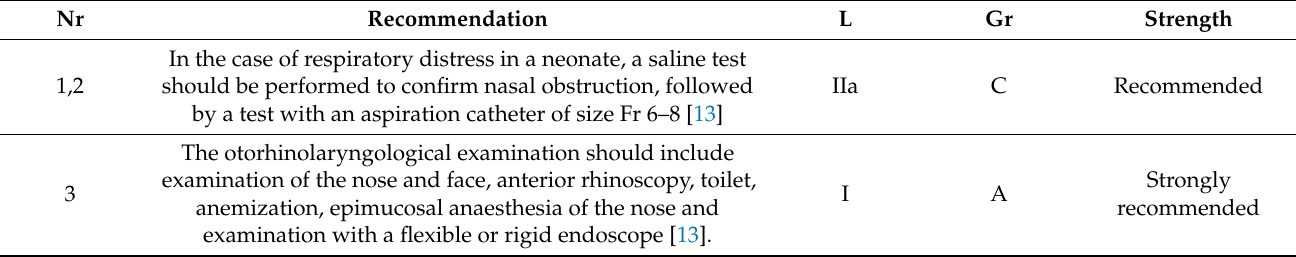
Table 2. Summary of Slovenian recommendations for the management of choanal